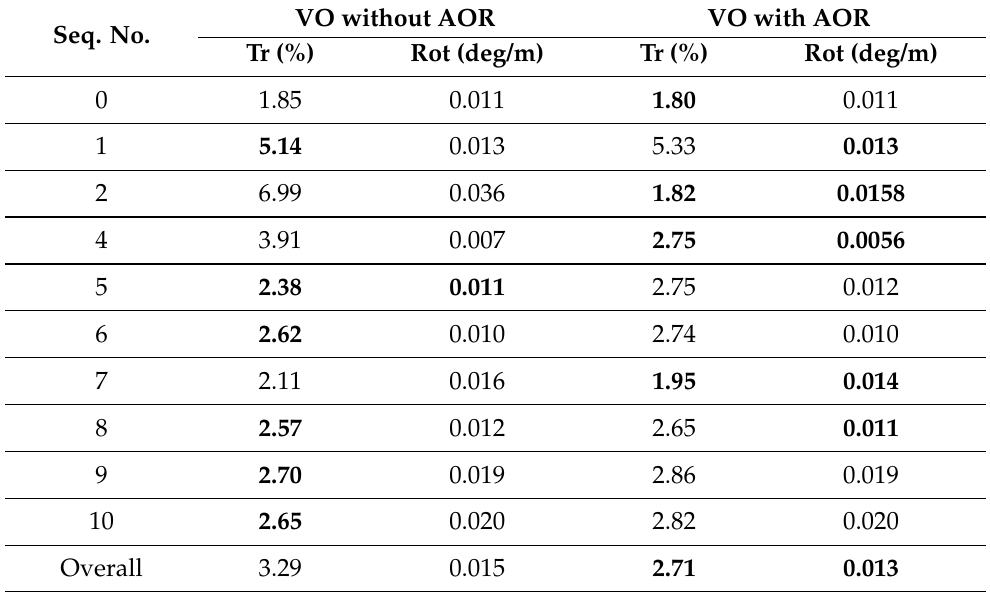
Table 2. AOR effect on pose